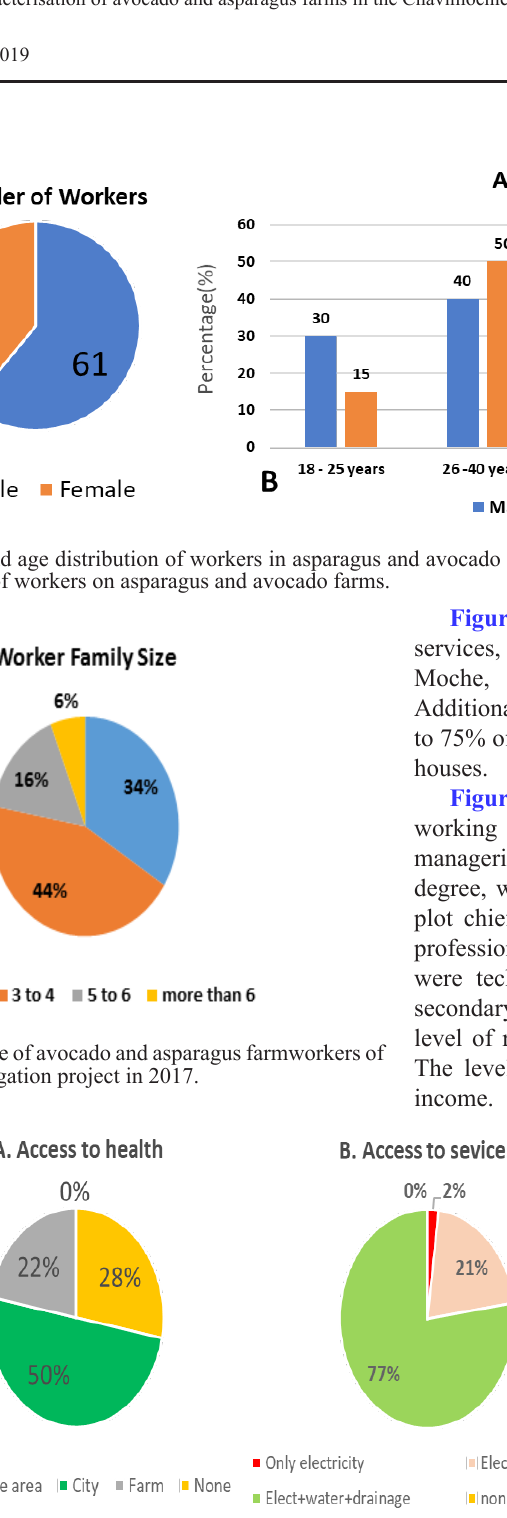
Figure 14. Access of farmworkers of avocado and asparagus farms to various services. (A) Access to health. (B) Access to services at the place of residence. (C) Home ownership of